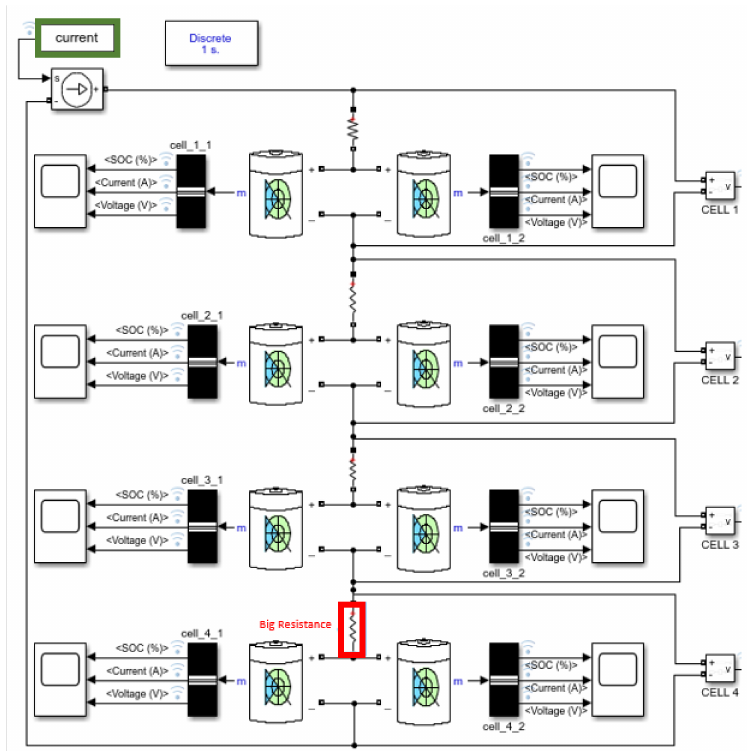
Figure 7. Simulation of a caravan battery pack with a resistance